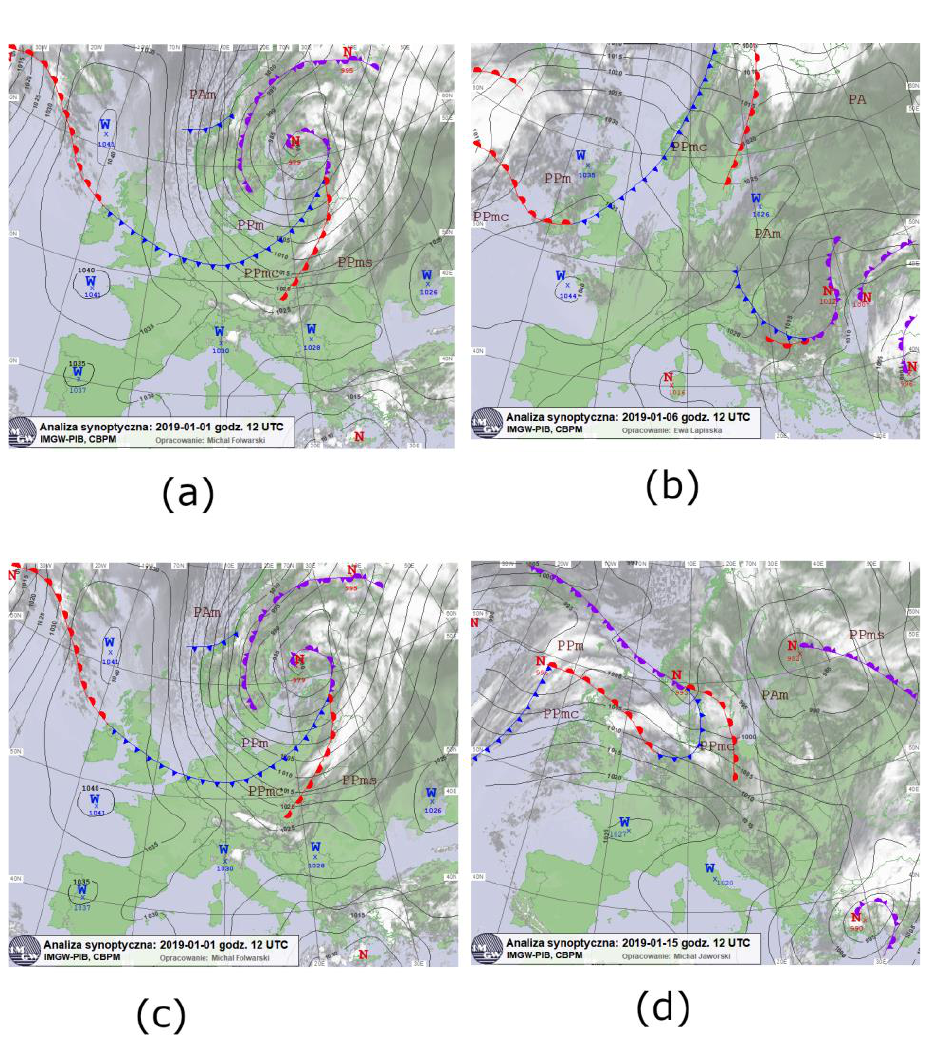
Figure 11. Meteorological conditions over Europe on IMGW-PIB weather maps from 4